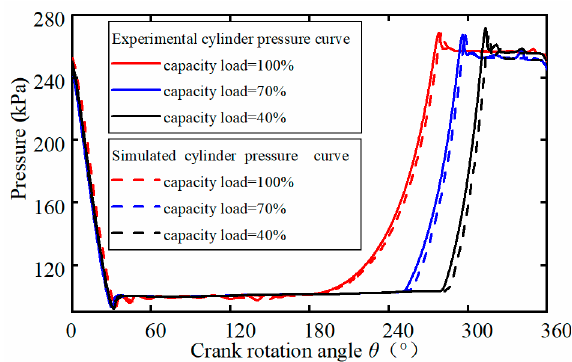
Figure 5. Dynamic pressure in the cylinder under di ff erent loads.